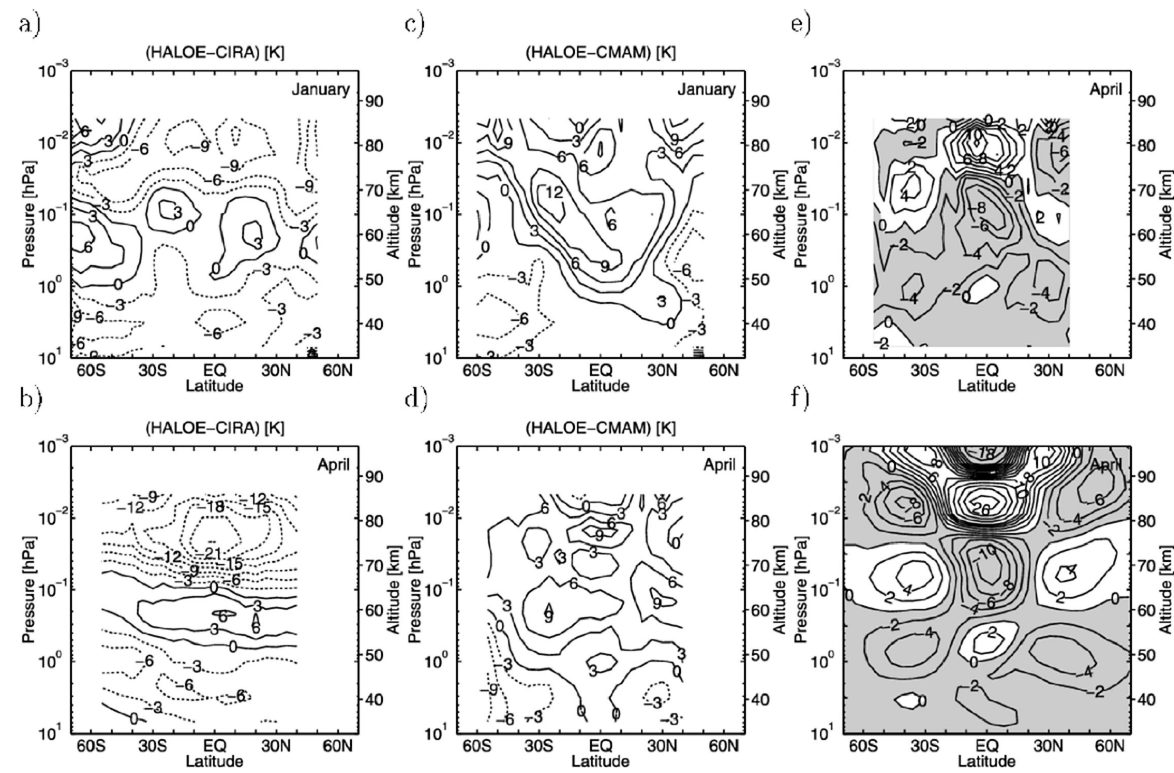
Fig. 4. Comparison between HALOE temperature measurements and the CIRA and CMAM models (after Jonnson et al.,